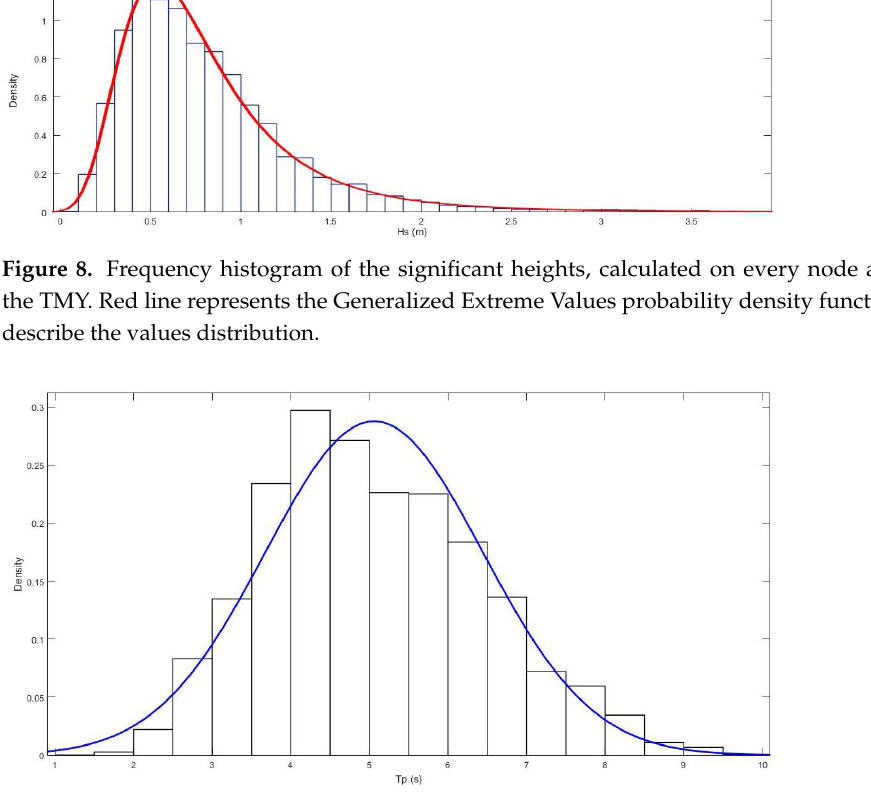
Figure 9. Frequency histogram of the peak period, calculated on every node and during the TMY. Blue line represents the Normal probability density function used to describe the values